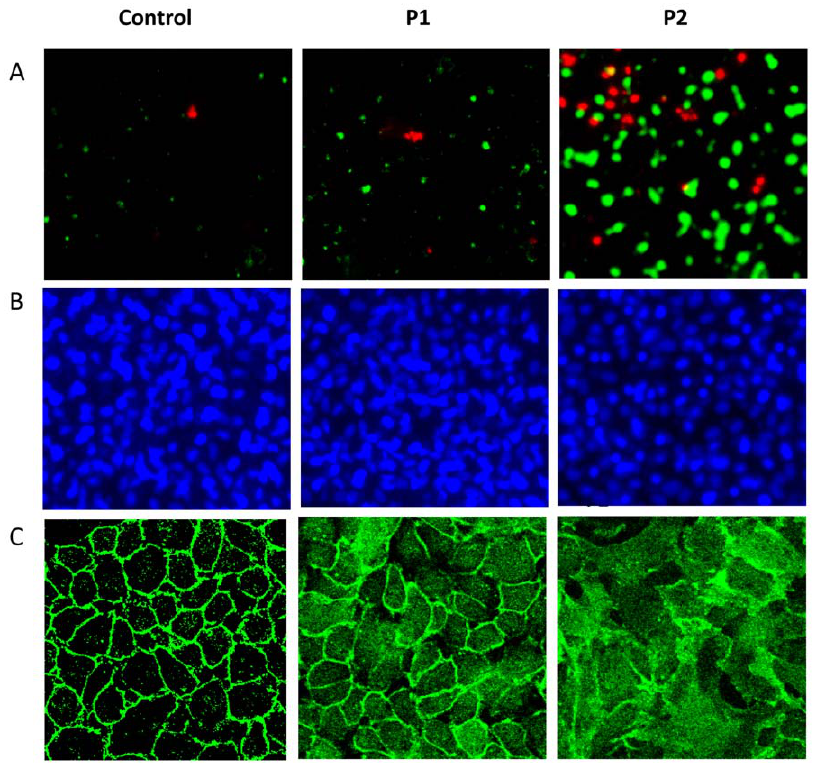
Figure 4. P2 induces significant apoptosis and structural changes in the tight junction protein ZO-1 in in IEC-18 monolayers. (A) IEC- 18 cells infected with P1 and P2 for 3 hrs were analyzed for apoptosis and necrosis with Apoptic&Necrotic&Healthy Cells Quantification kit (Biotium, Inc.) using fluorescence microscope Axiovert 35 (Zeiss,Germany). FITC-Annexin V (apoptotic cells, green), EtD-III (necrotic cells, red). (B) Staining of nuclei with Hoechst 33342. (C) IEC-18 monolayers treated with antibody to ZO-1.